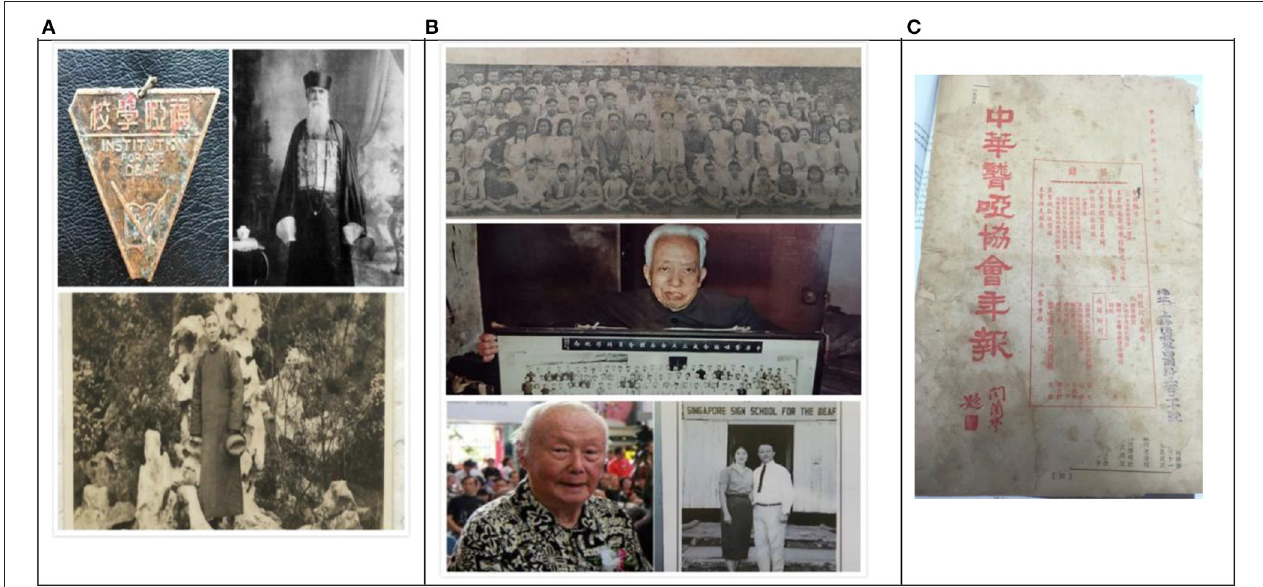
FIGURE 4 | Information about Fryer Deaf, Zhonghua Deaf, and Mr. Peng a . (A) Badge of Fryer, Mr. Fryer, and Mr. Wang. (B) Photos of deaf students and teachers at Zhonghua in 1941, Mr. He, Mr. Peng, and Mr. Peng in the 1950s. (C) Annual magazine of the China Deaf Association. a Mr. Peng’s interview was conducted by my deaf friend Sheng Huan in Singapore in 2016. When we were planning to arrange another interview in 2018, we were informed of his passing away. The photo was downloaded from an online magazine in Singapore. Available online at: http://www.zaobao.com/keywords/peng-zhu-en (retrieved February 10,